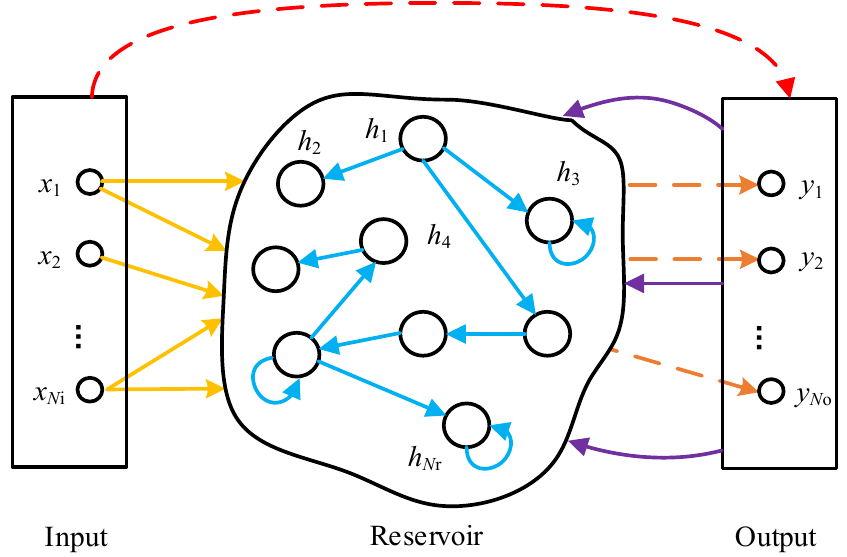
Figure 2. Detail structure of ESN. W r in yellow line, W r r in blue line, W r o in purple line, W o in red line, W o r in orange line. Also, trainable connections are shown with dashed lines and random connections are shown with solid lines.